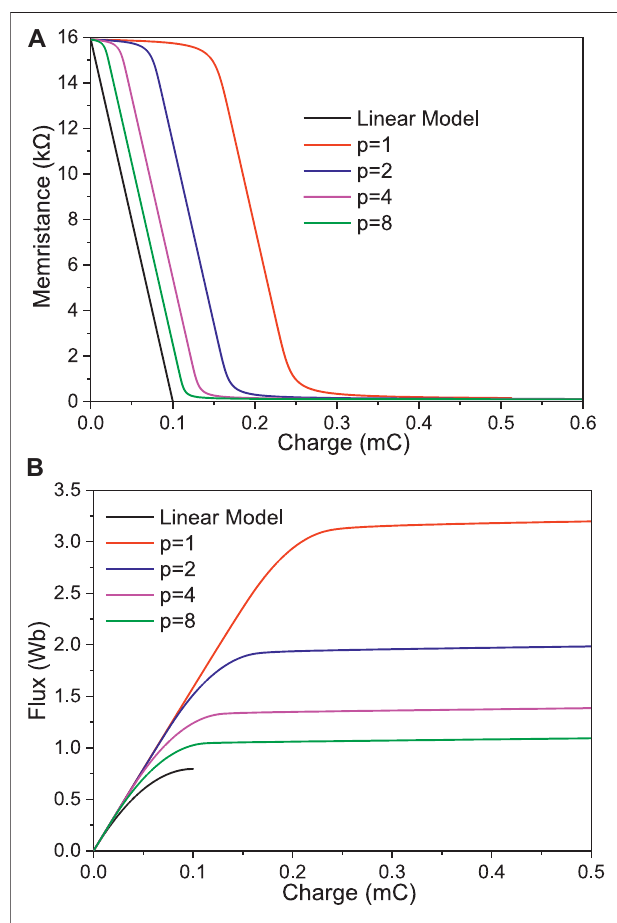
FIGURE 8 | (A) Memristance versus charge curves and (B) fl ux versus charge curves for the linear and nonlinear model of memristor.